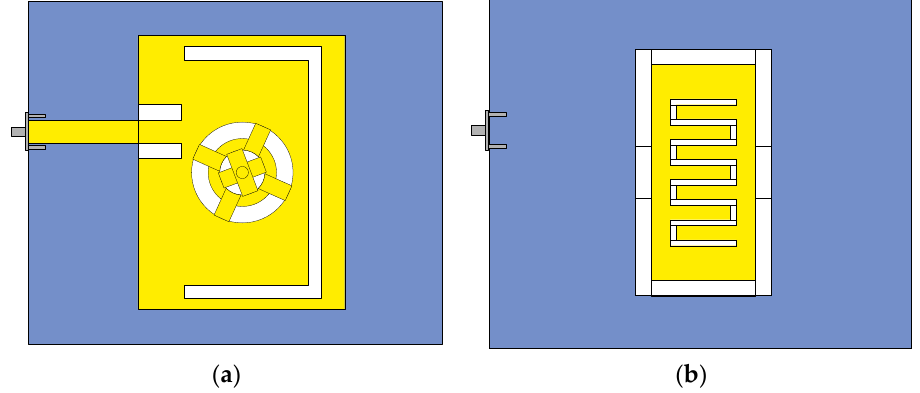
Figure 8. Final antenna layout for the three-frequency bands optimization case, after the optimization process; ( a ) Front view; ( b ) Bottom view.